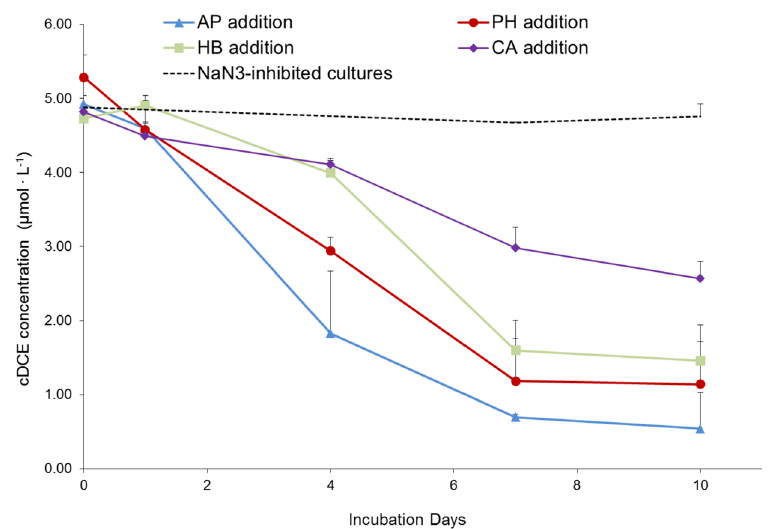
Figure 3. Average depletion of cDCE over time in the aqueous phase for the cultures enriched on acetophenone ( AP ); trans -cinnamic acid ( CA ); p -hydroxybenzoic acid ( HB ); and phenethyl alcohol ( PH ) (three biological replicates were used per each condition). Dashed line indicates the over-time cDCE concentration in sodium azide-inhibited cultures grown on acetophenone and p -hydroxybenzoic acid (two biological replicates were used per control condition). The error bars indicate the standard deviation among biological